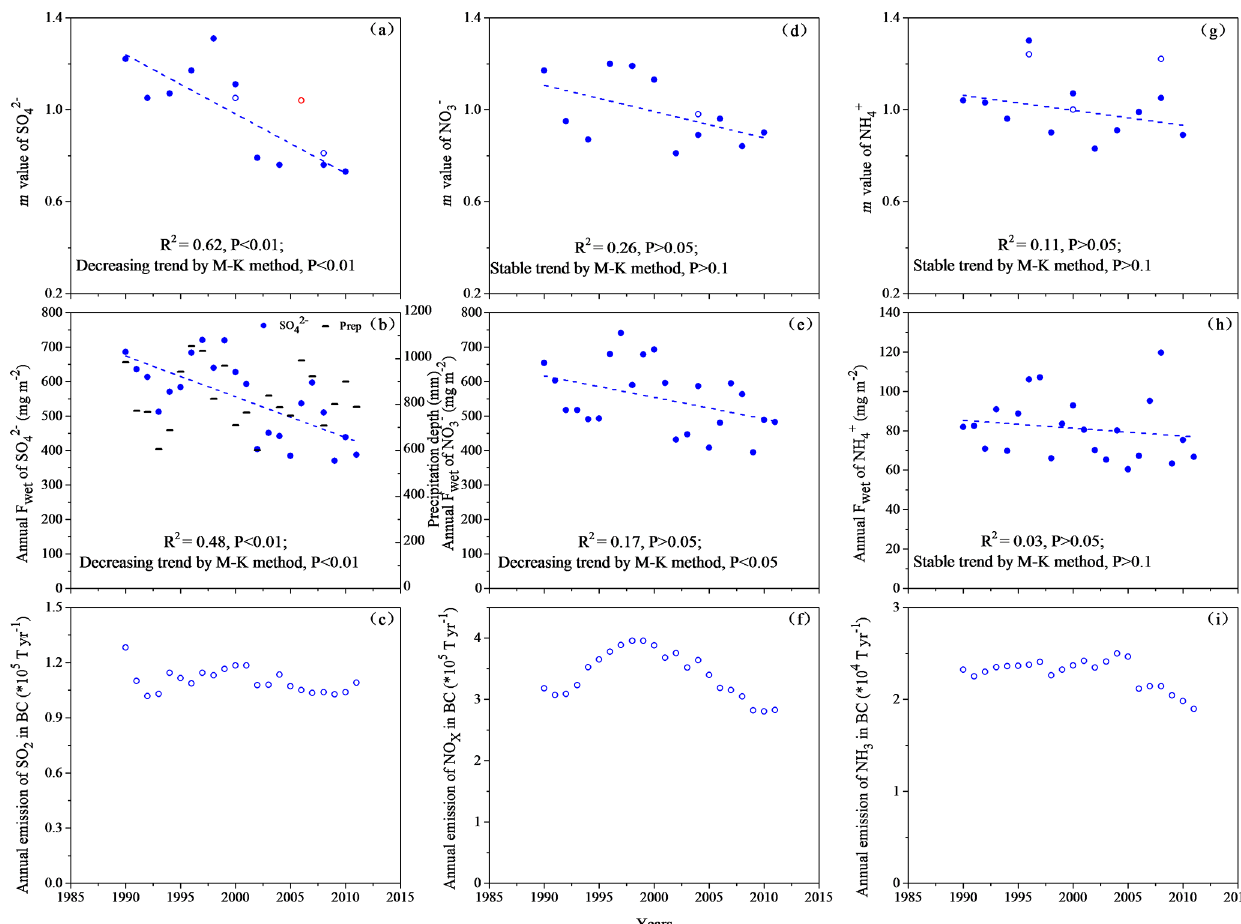
Figure 3. Same as in Fig. 2 except for Site 2, and the annual precipitation and annual emissions in British Columbia, Canada. Horizontal dashes in (b) represent precipitation, and the fitted lines represent the LR